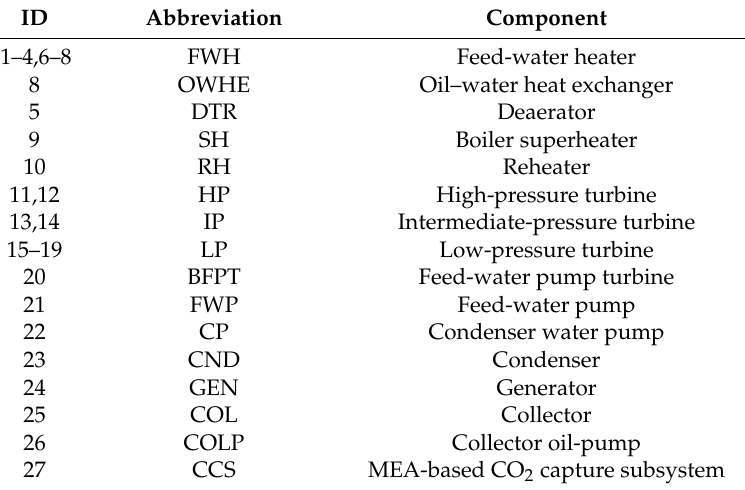
Table A1. Abbreviations and